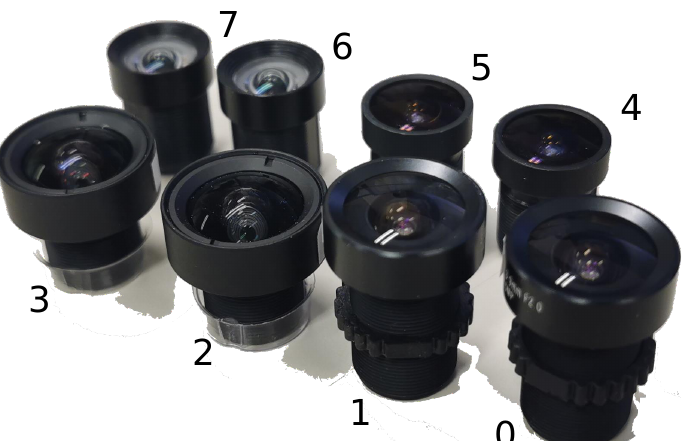
Figure 7. An illustration of the eight lenses that were used in our experiments. Lenses 0 to 3 are high resolution, while Lenses 4 to 7 are low resolution. The imaging capability of Lens 0 is very inconsistent, while Lens 1, Lens 4 and Lens 5 are a little bit inconsistent and the remaining four lenses are